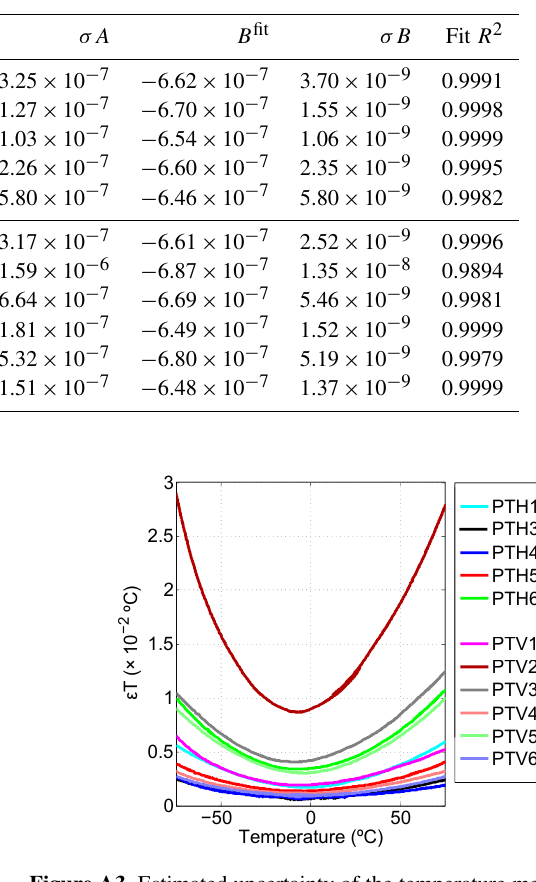
Figure A3. Estimated uncertainty of the temperature measurement of each calibration sensor versus temperature, based on the indi- vidual fits of the laboratory calibration measurements to the CVD equation. After calibration, almost all sensors have an uncertainty below 0.01 ◦ C over the indicated temperature